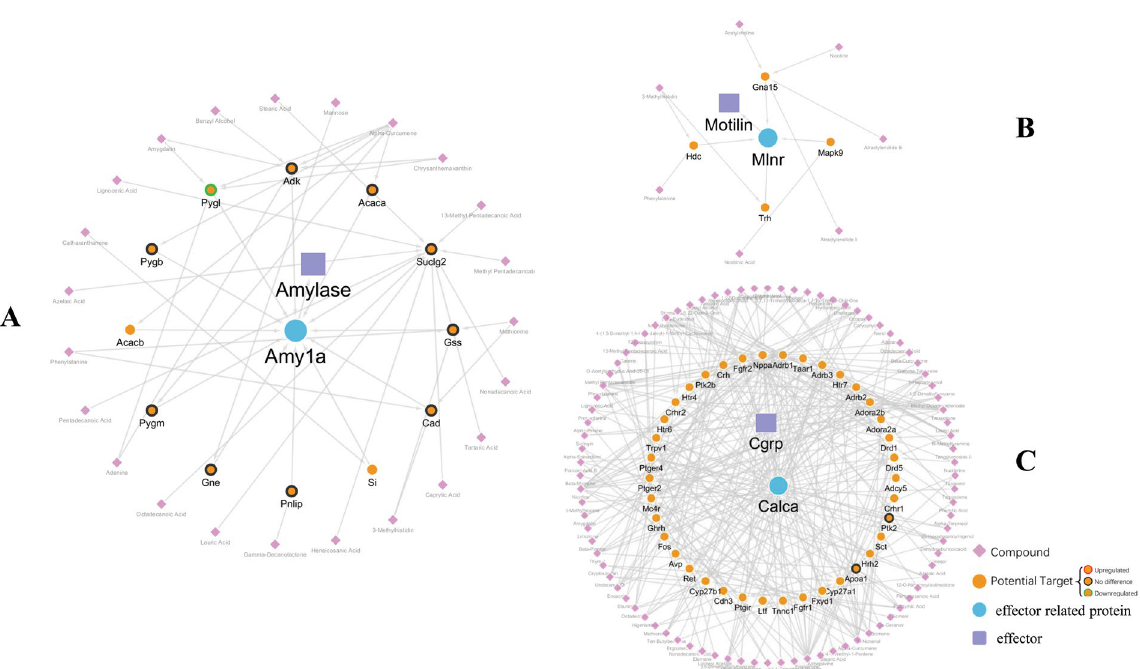
Figure 4. Network of interactions among the chemical components of XEFP, predicted and identified protein targets, and effector molecules regulated by XEFP against FD. ( A ) Effector molecule: amylase ( B ) effector molecule: motilin ( C ) effector molecule: